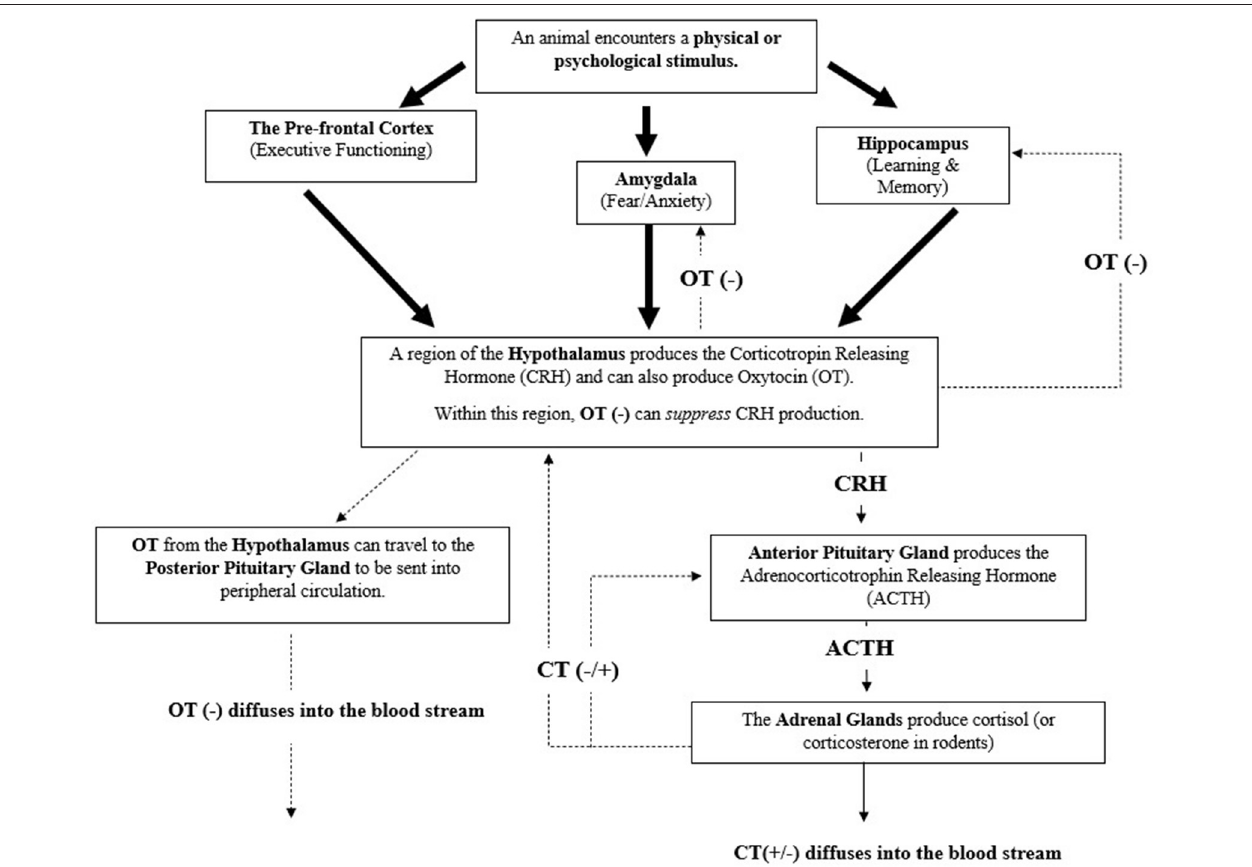
FIGURE 1 | The mammalian hypothalamic pituitary-adrenal axis (HPA) and a summary of its complex relationship with the hormones Cortisol (CT) and Oxytocin (OT) ( 61–64) Negative feedback (represented by minus signs) can be initiated by oxytocins to lesson cortisol’s production. Cortisol can act as a negative or positive feedback mediator (represented by plus sign) to further lesson or amplify its production, respectively. Large arrows represent sensory signals that are integrated to initiate the HPA